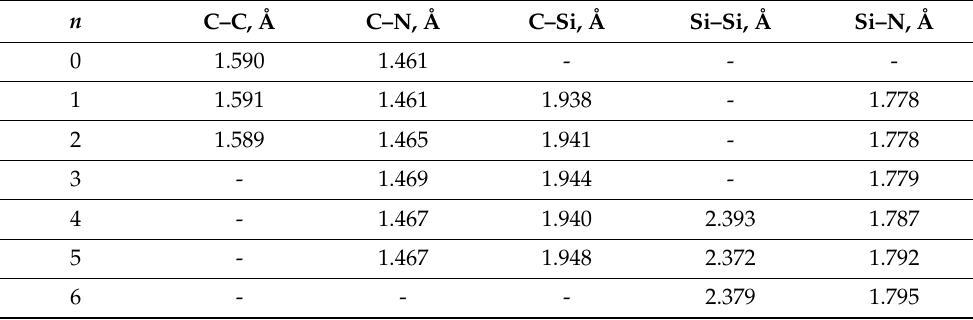
Table 2. The average bond lengths of the most thermodynamically stable compounds Si n CL-20 obtained at the DFT/B3LYP/6-311G(d,p) level of theory. A dash “-” means that this bond is not found in the compound.